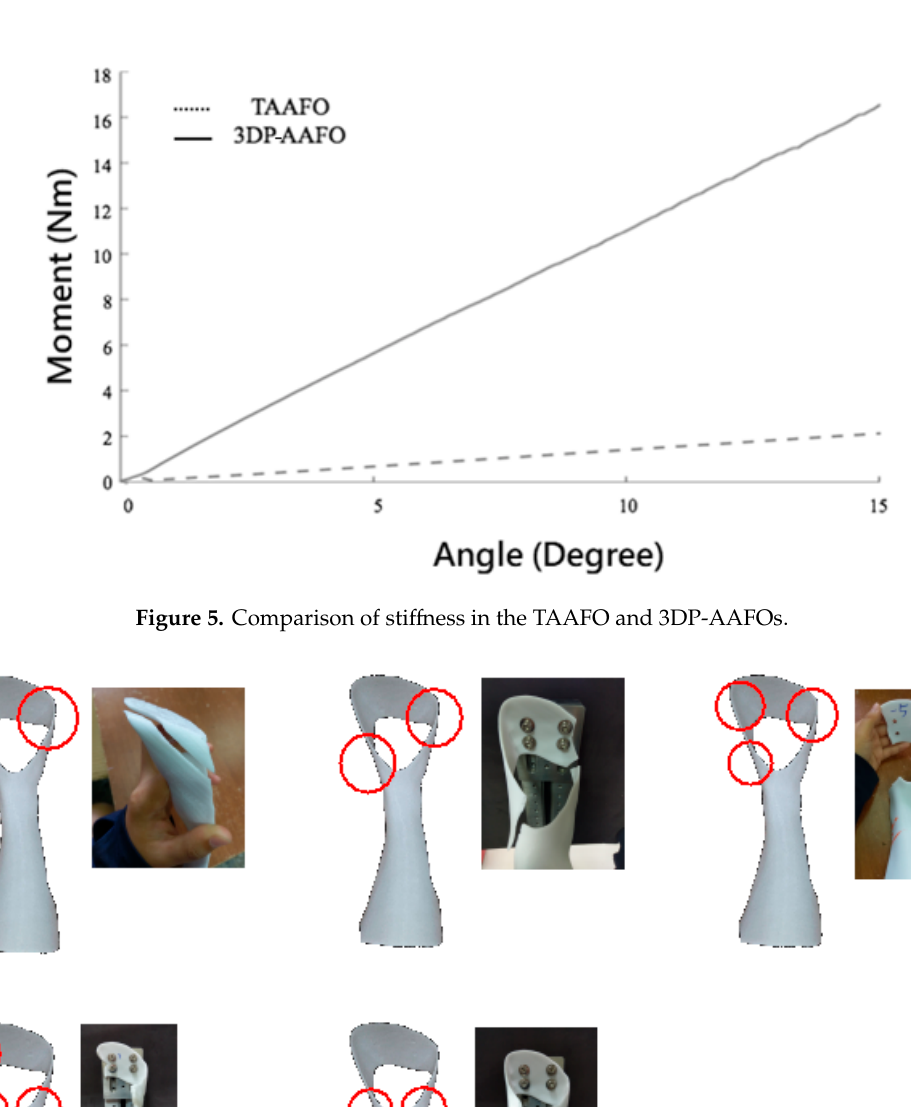
Figure 6. Different patterns of the fractured 3DP-AAFOs. Circle indicates the locations of the fracture.